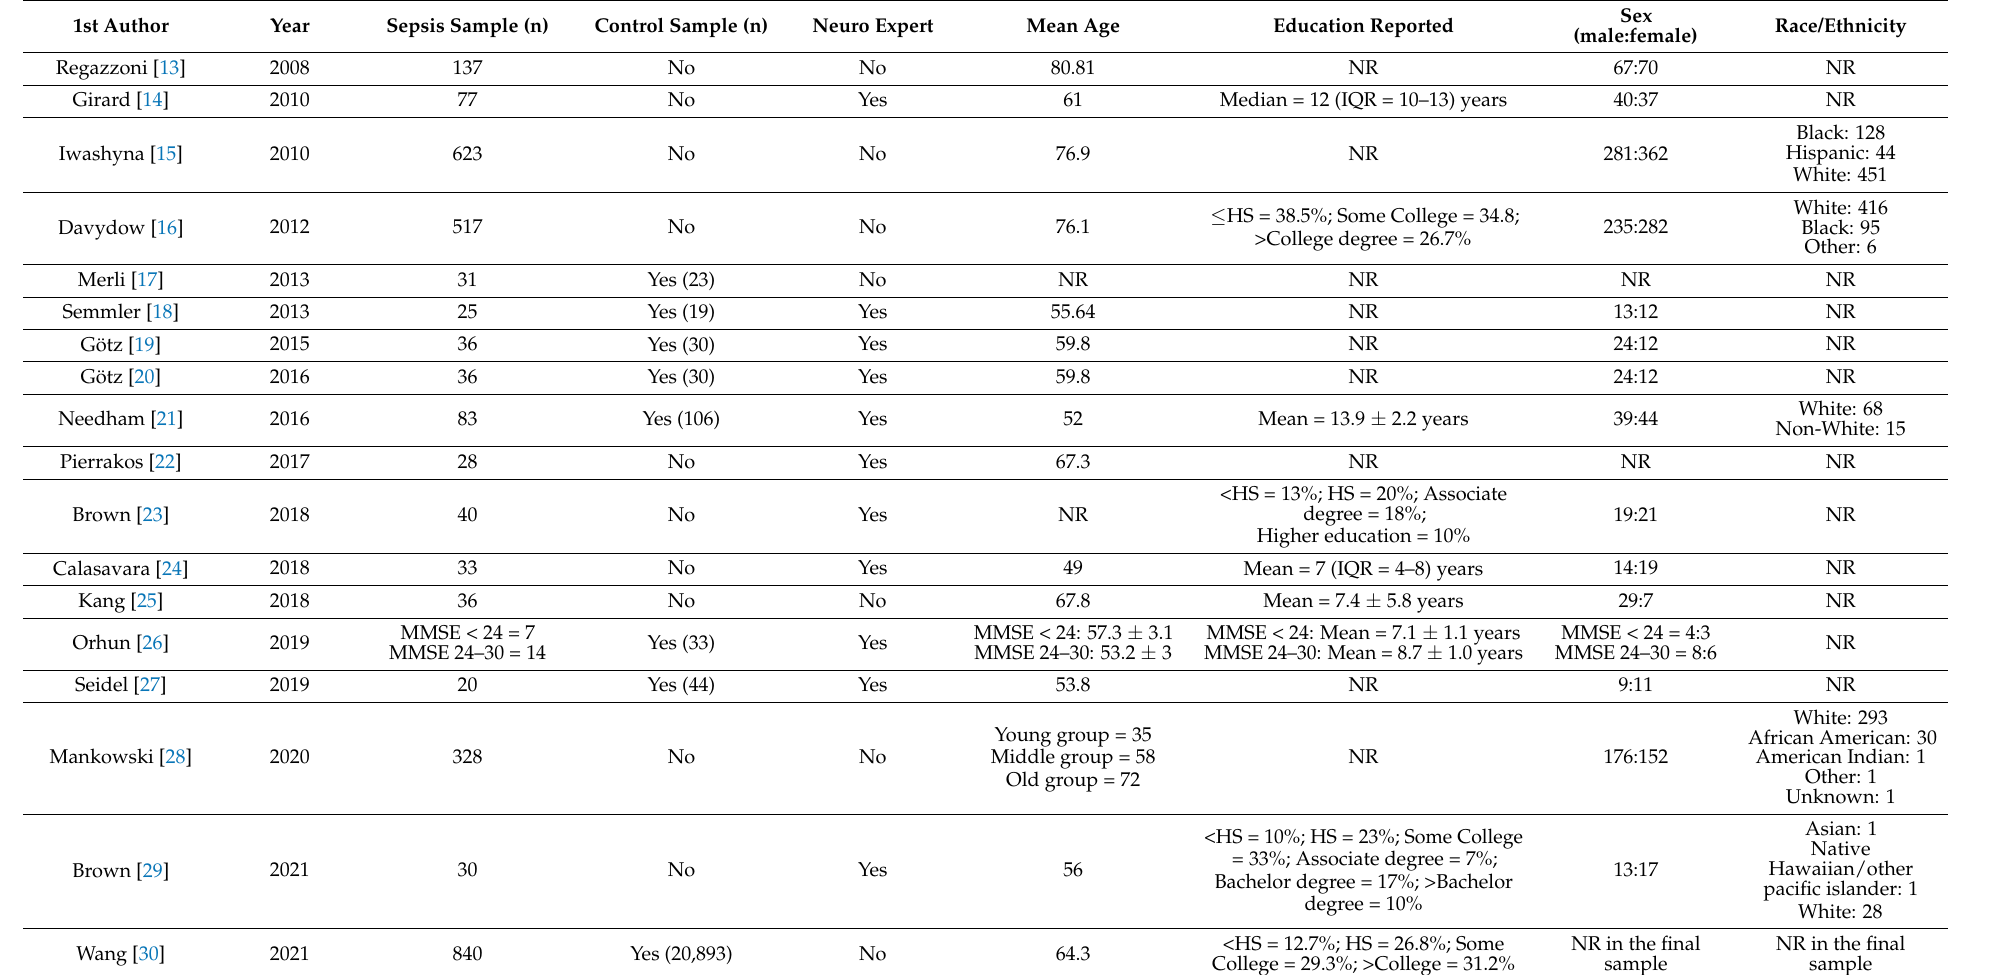
Table 1. Demographic characteristics of the retained